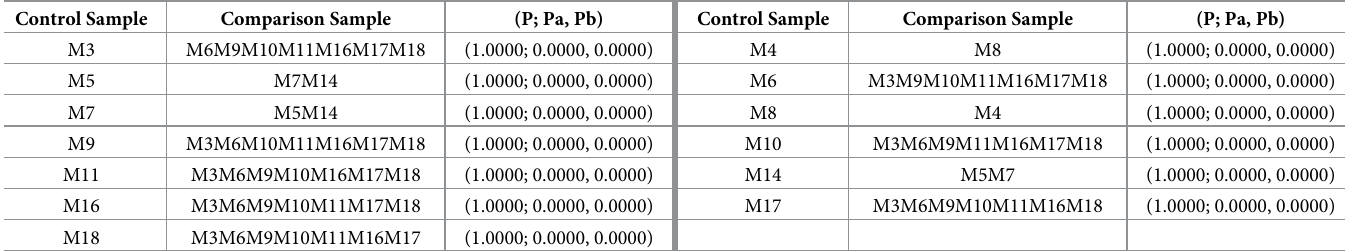
Table 5. The sequence with the same absorption peak (Group A).